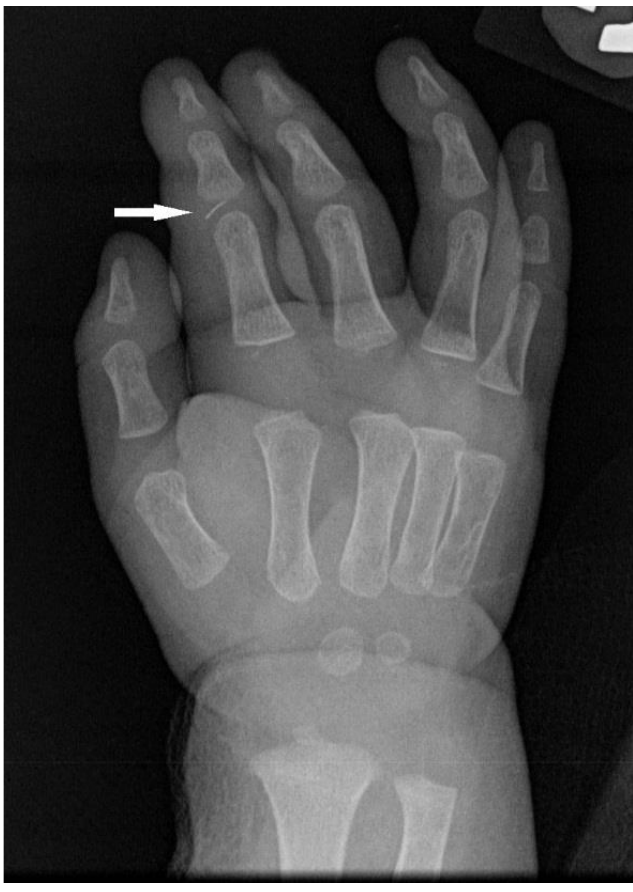
Image 2. Radiograph of right hand: Note the foreign body within the index finger proximal inter-phalangeal joint